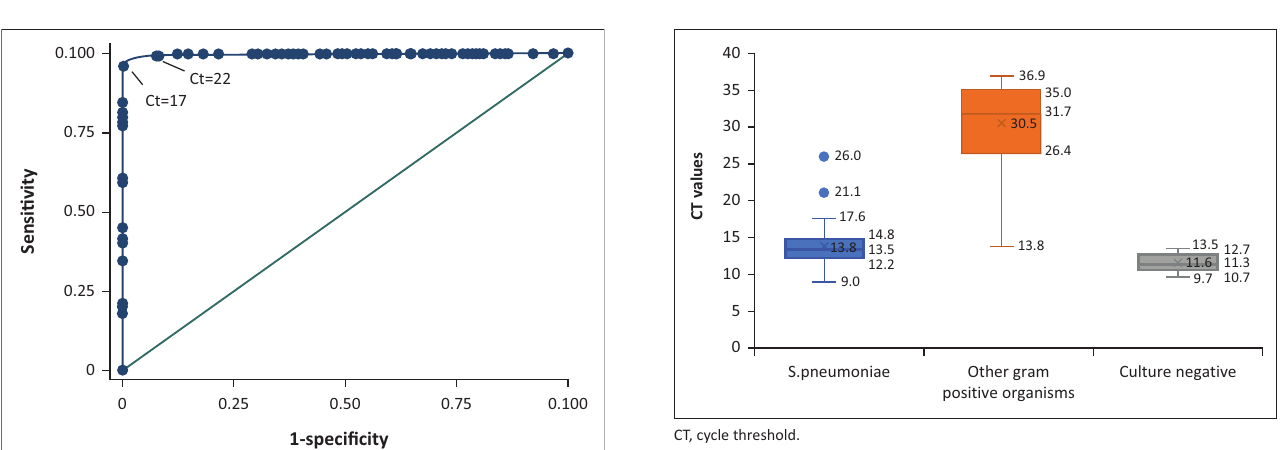
FIGURE 2-A1: Distribution of PCR cycle threshold (CT) values using box and whisker diagrams, in signal-positive blood culture samples that have been grouped based on culture results. Whiskers represent the minimum and maximum values of the CT-values and boxes represents the interquartile range. ‘X’ represents the mean of CT-values. For the S. pneumoniae group, there were 2 CT-values that were outliers (excluded from box and whisker diagram) and these are represented by dots in the figure.